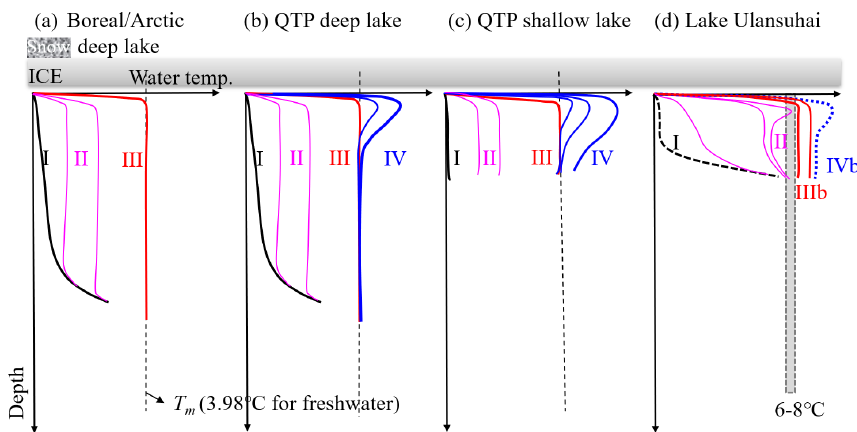
Figure 9. Typical thermal stratification types in ice-covered lakes: (a) deep lakes in the Arctic (Jakkila et al., 2009), (b) deep lakes on the QTP (Kirillin et al., 2021; Lazhu et al., 2021), (c) a shallow pond on the QTP (Huang et al., 2019b), and (d) Lake Ulansuhai. The definitions of Roman numerals are presented in the